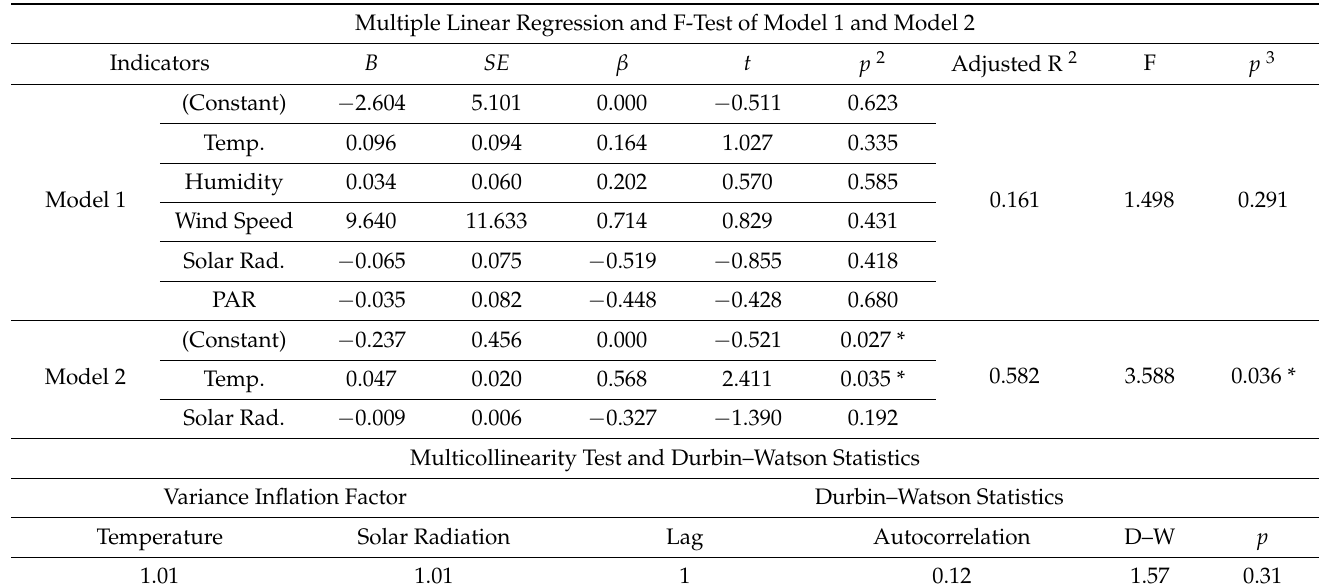
Table 4. Results of regression analysis of experimental site (500 trees/ha). Multiple Linear Regression and F-Test of Model 1 and Model